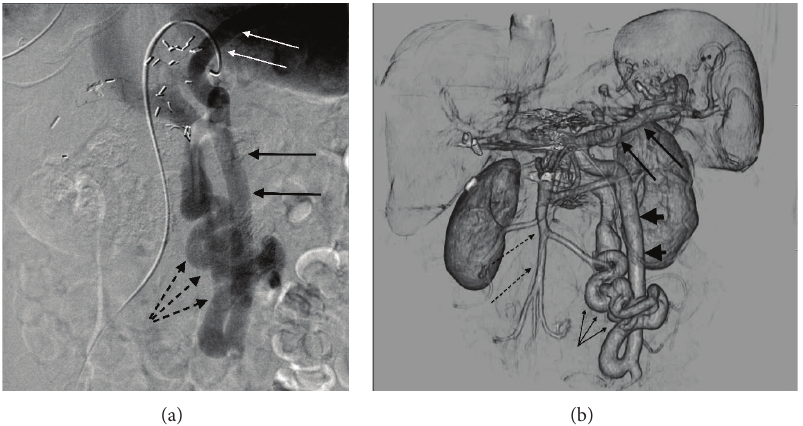
Figure1:(a)Visceralphaseangiographyfollowinginjectionofthesplenicarterybeforeocclusionoftheportosystemicshuntshowsretrograde flow from the splenic vein (white arrows) via an enlarged inferior mesenteric vein (black arrows) via shunt (three dashed arrows) into the systemic venous system. (b) Venous phase volume-rendered (VR) image demonstrates a serpentine vascular shunt (three small arrows) connecting an enlarged IMV (large arrow heads) to the left renal vein via a tortuous shunt (three small arrows). The splenic vein is marked with three two large arrows. Normal appearance of the SMV (dashed arrows). Streak artifact in the portal confluence is due to clips from prior Whipple